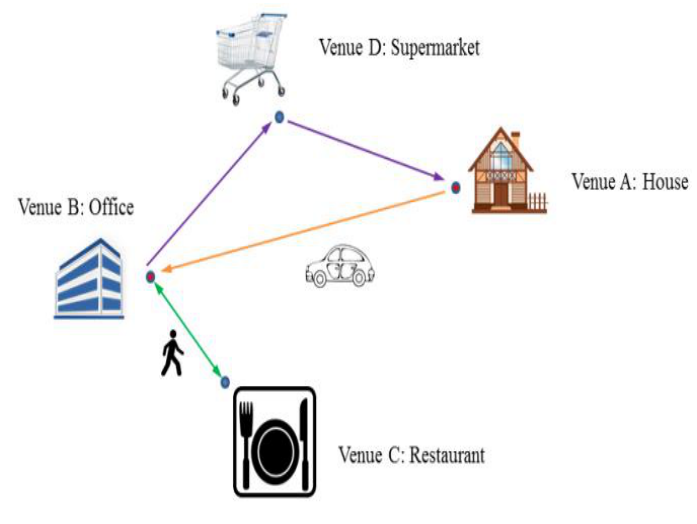
Figure 1. Examples of user